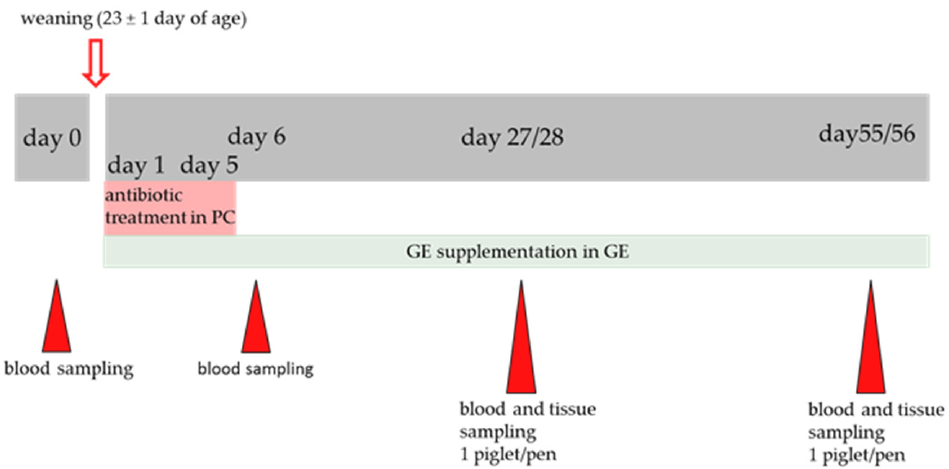
Figure 1. Study design and sampling overview. PC = positive control; GE = grape extract.